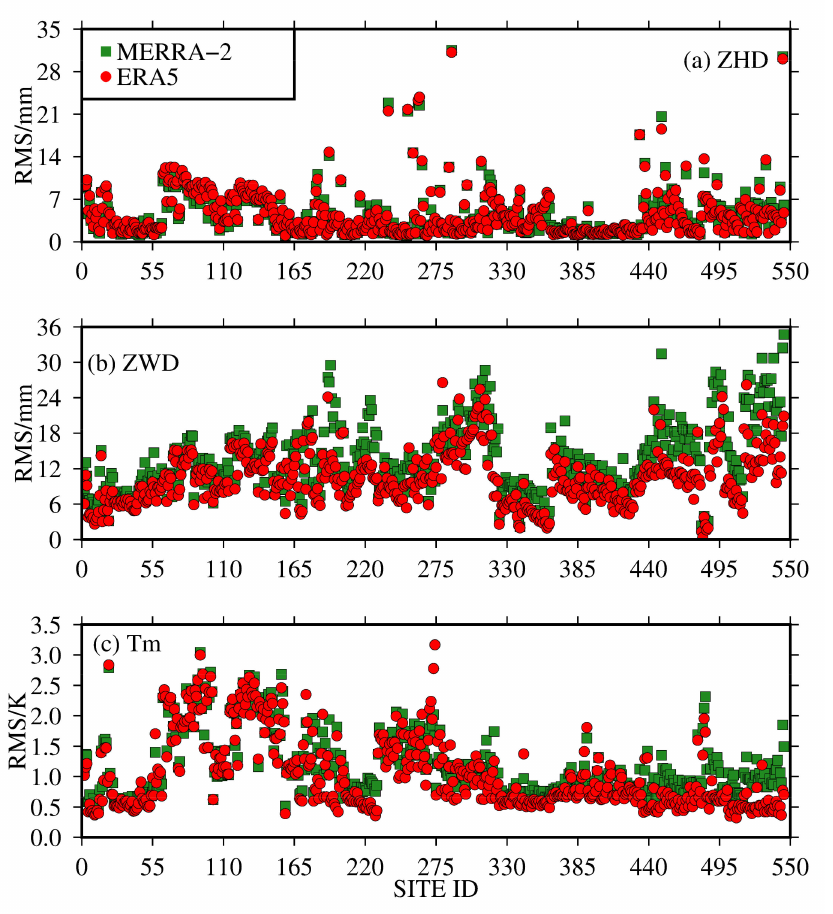
Figure 9. ( a – c ) RMS of ZHD, ZWD, and T m from ERA5 and MERRA-2 pressure-level data from 545 stations validated by radiosonde data from 2016 to